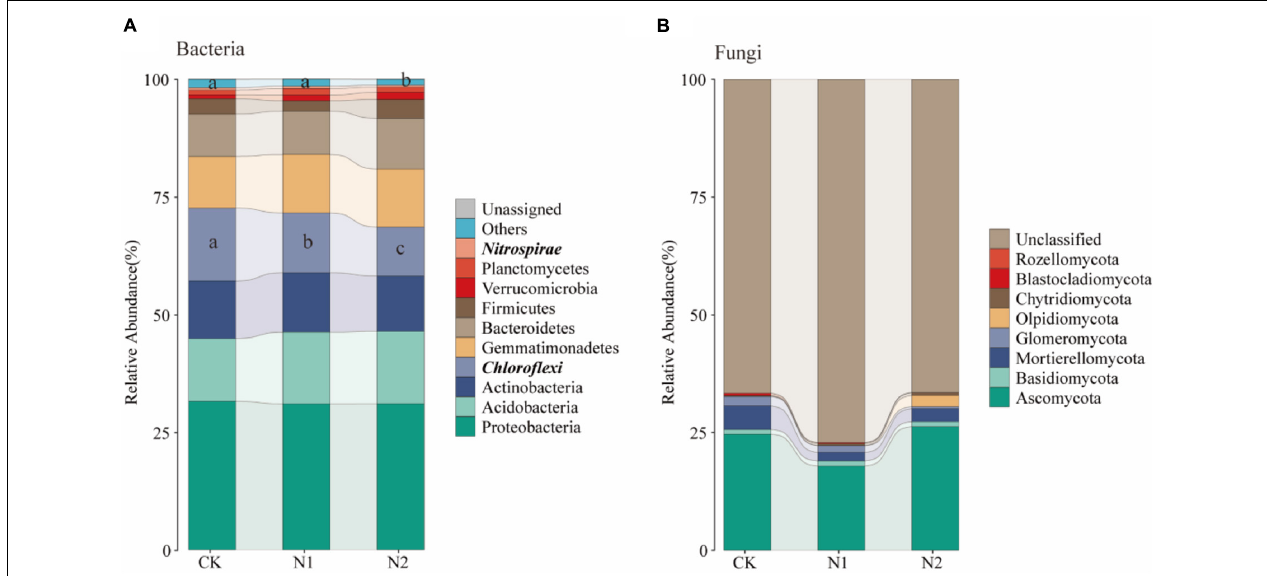
FIGURE 9 | Changes in soil microbial community structure after N application. (A) Changes in the top 10 bacteria at the phylum level. (B) Changes in fungi at the phylum level. Phylum level with significant differences are highlighted in bold italics.